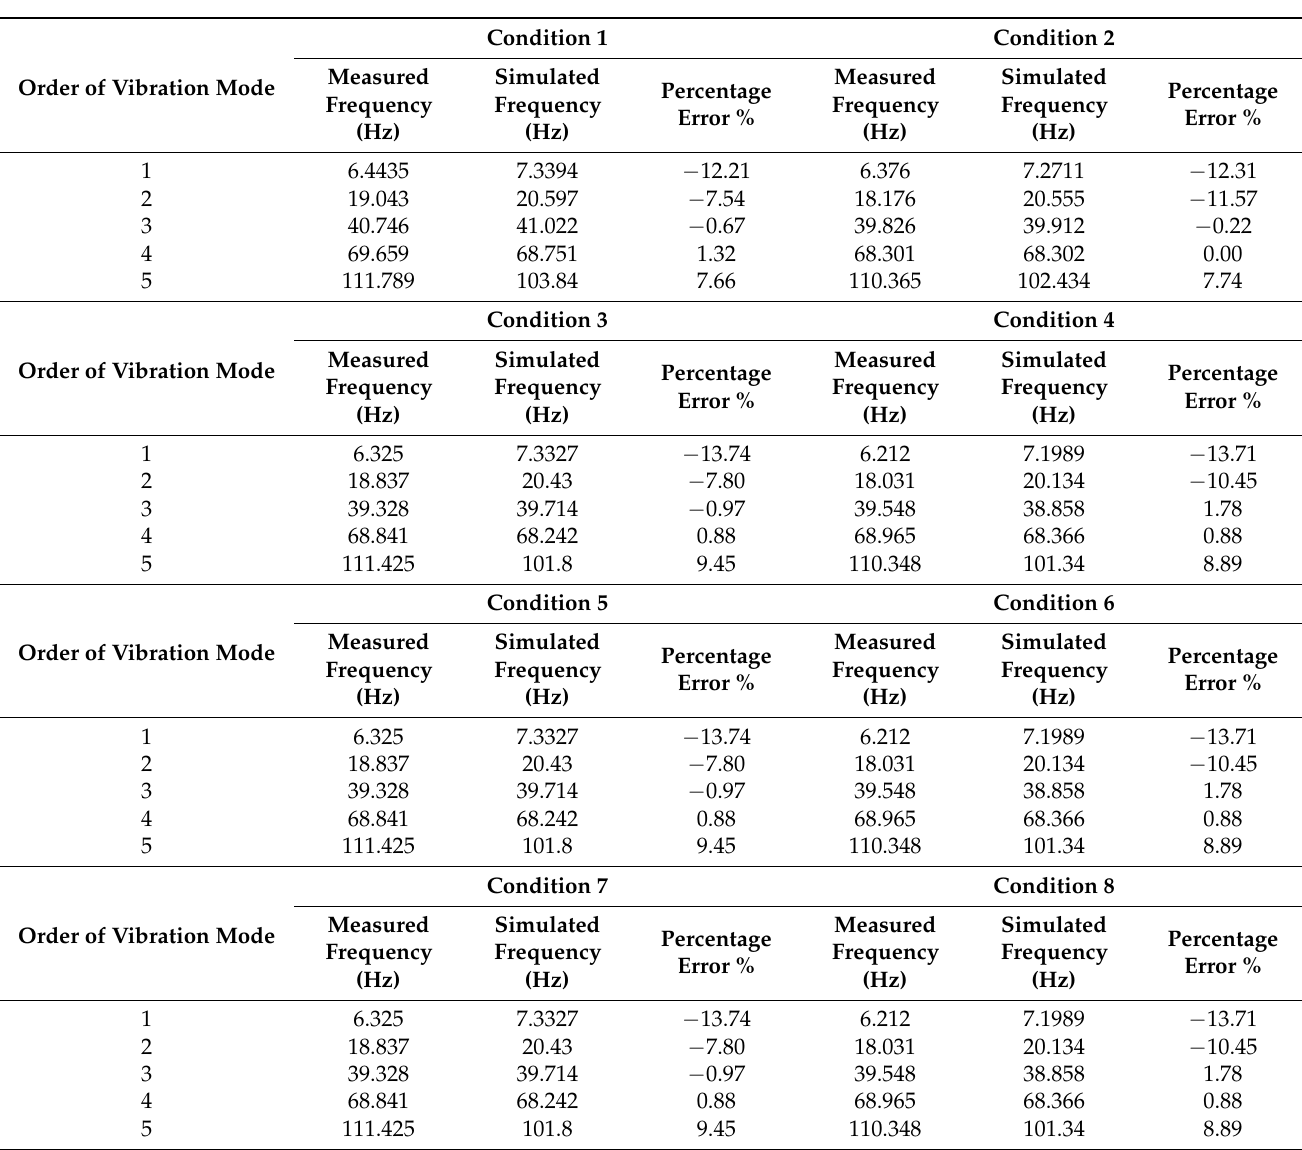
Table 5. Inherent frequency